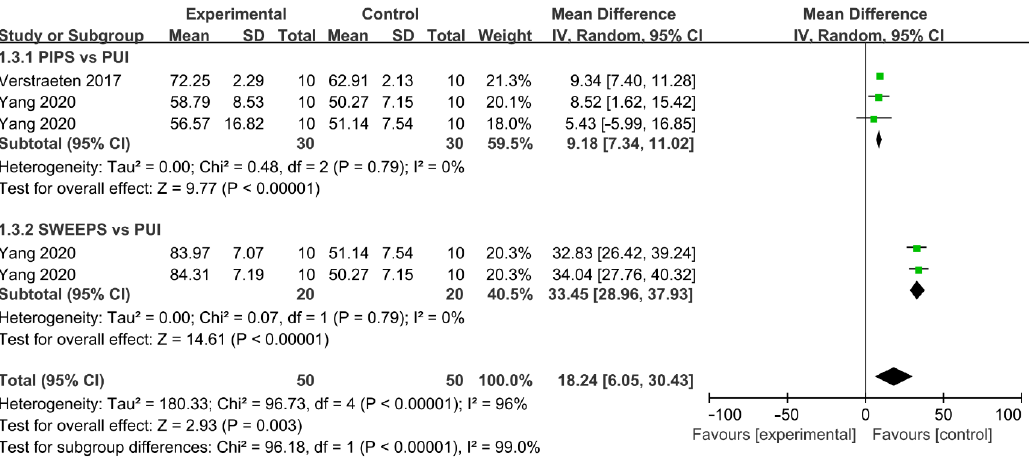
12 of 21 Figure 7. Forest plot and meta ‐ analysis of comparison between mechanical ‐ activated system and PUI [37,38,40,42,43]. 3.3.5. Laser ‐ Activated Irrigation System Comparation of percentage reduction in AHTD between LAI and PUI was reported by two studies, with a total of 100 teeth involved (Figure 8) [15,41]. One comparison was included in Verstraeten and two independent comparisons were conducted in Yang. The irrigation efficacy significantly increased in LAI compared with that in PUI (WMD: 18.24, 95% CI: 6.05 to 30.43; p = 0.003). A subgroup analysis based on laser ‐ activated instruments